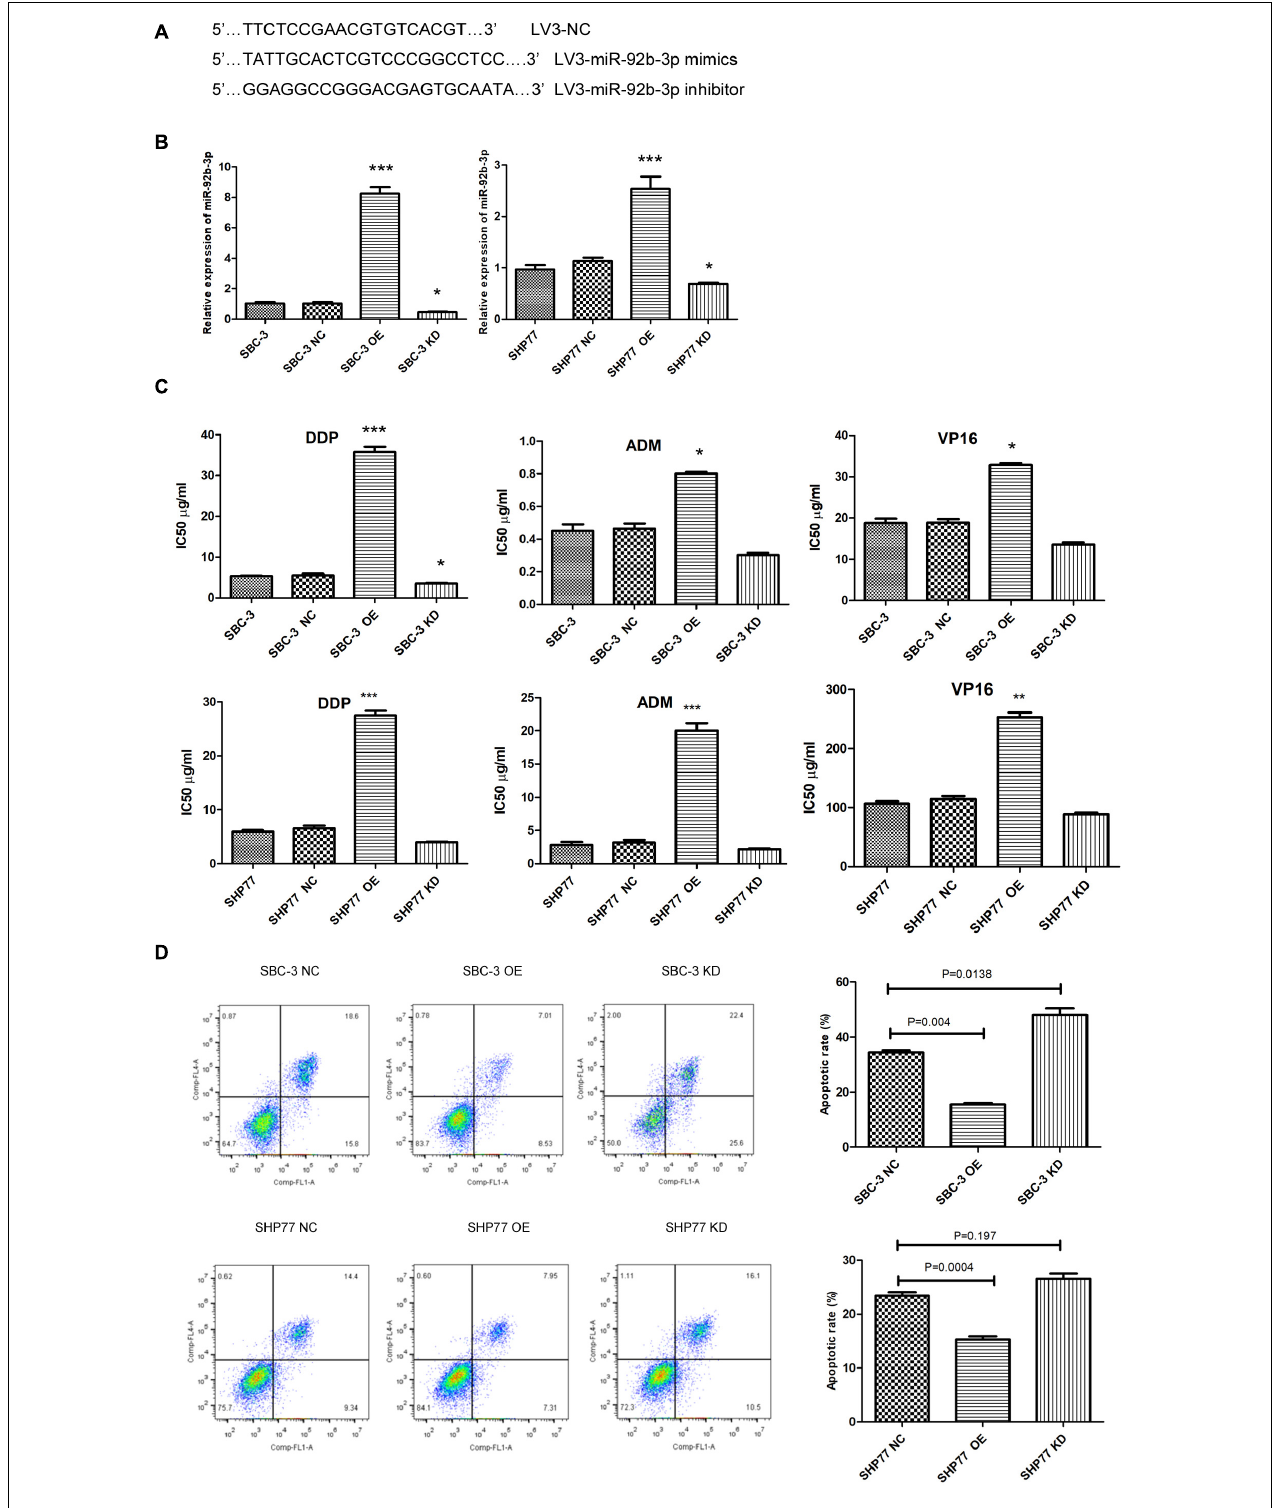
FIGURE 2 | MiR-92b-3p promotes chemoresistance and inhibits apoptosis in SCLC cells. (A) Primer sequences of lentiviral miR-92b-3p. (B) The miR-92b-3p levels were increased in SCLC OE cells and decreased in SCLC KD cells. (C) IC50 of DDP, ADM, and VP16 in SCLC cells. MiR-92b-3p promoted chemoresistance in SCLC cells. (D) MiR-92b-3p inhibited SCLC cell apoptosis. OE, miR-92b-3p overexpression; KD, miR-92b-3p knockdown. (B–D) analyses were performed in triplicate. SCLC, small cell lung cancer; DDP, cisplatin; ADM, adriamycin; and VP16, etoposide. * P < 0.05, ** P < 0.01, *** P < 0.001.